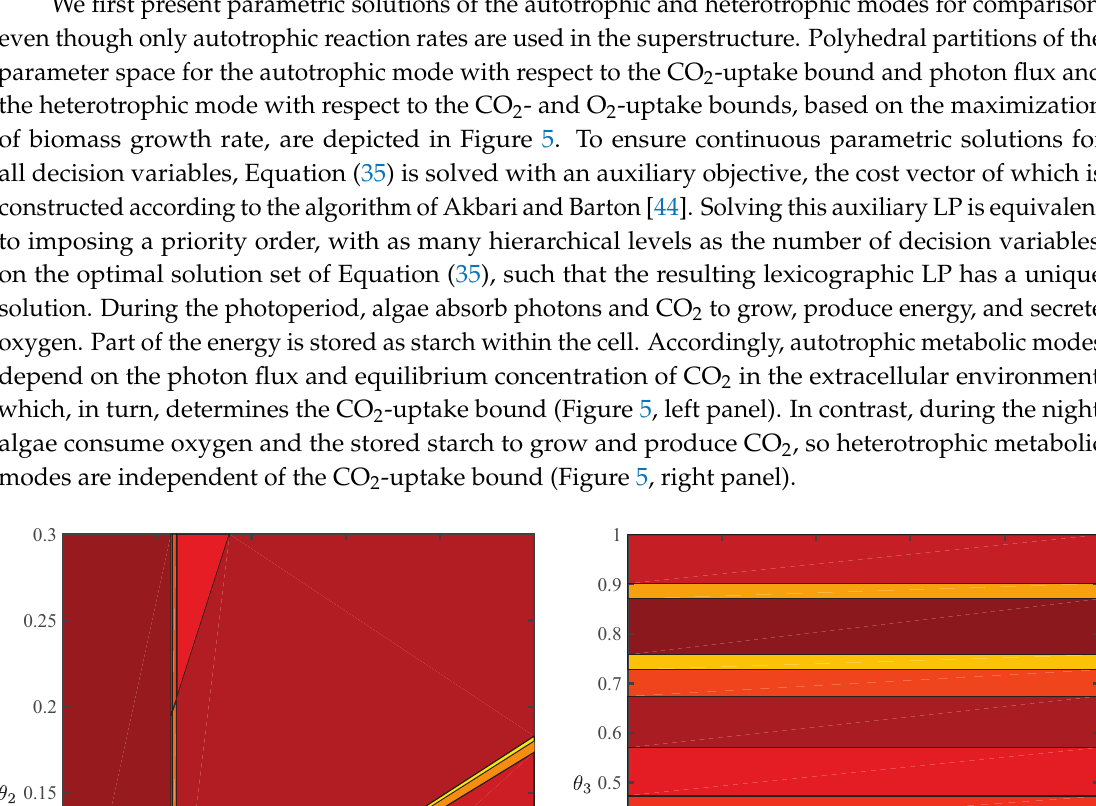
/ v max,CO , θ 2 = CO 2 2